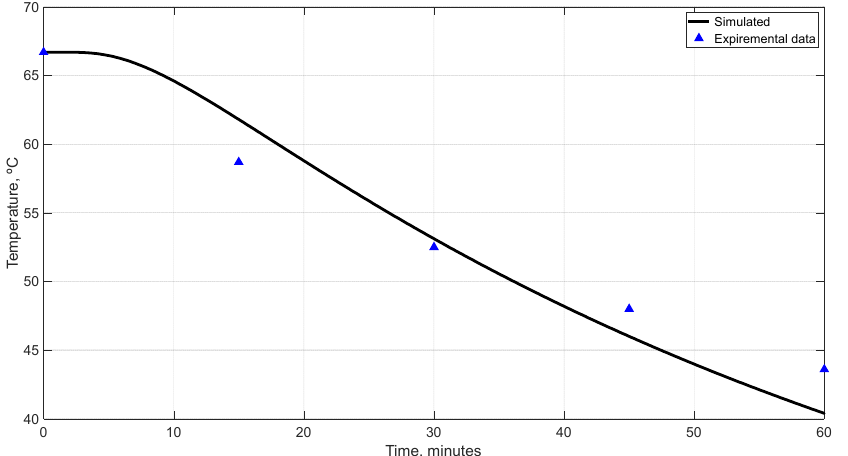
Figure 9. Comparison between experimental and simulated data for the PET temperature at the bottle centre.